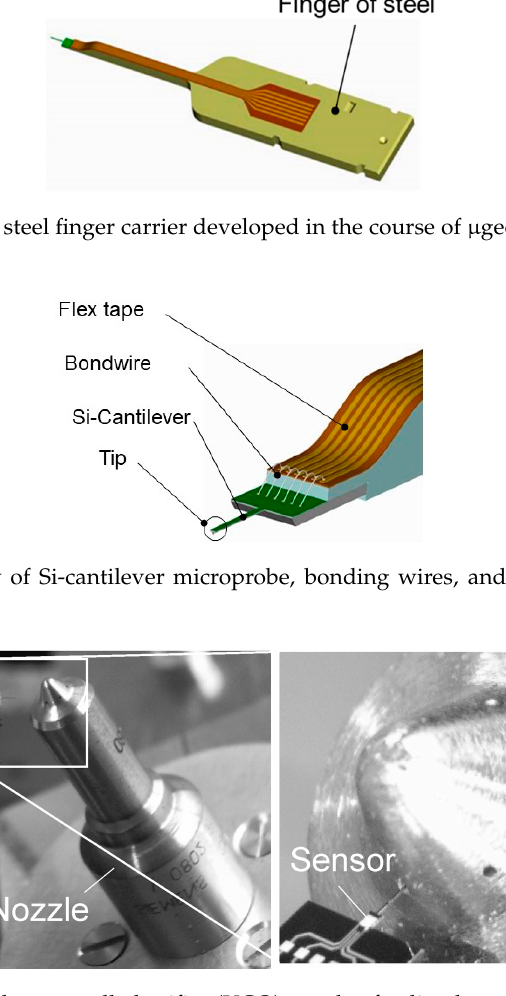
Figure 40. A prototype valve controlled orifice (VCO) nozzle of a diesel engine and the microprobe entering one of the spray holes for surface quality